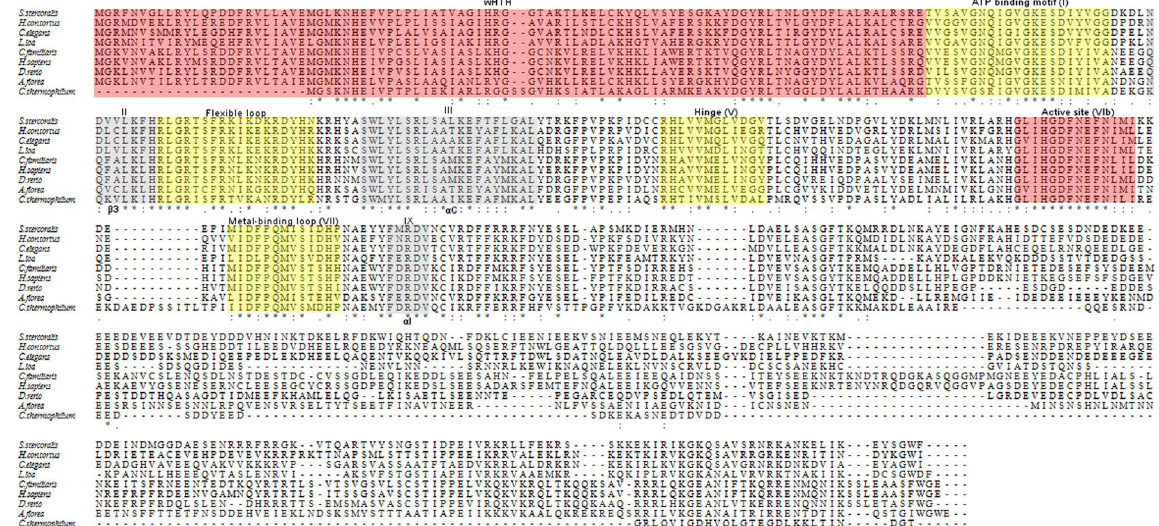
Figure 1. Multiple sequence alignment among predicted RIOK-2 proteins from eight organisms ( Strongyloides stercorali s, Loa loa , Haemonchus contortus , Caenorhabditis elegans , Apis florea , Danio rerio , Canis familiaris , Homo sapiens , Chaetomium thermophilum ). The N-terminal domain contains the conserved wHTH do main (red). The RIO kinase domain contains the ATP-binding motif (yellow), the flexible loop (yellow), the hinge region (yellow), and the catalytic (red) and metal-binding loops (yellow) as determined from the structure of the Archaeoglobus fulgidus RIOK-2 protein. The predicted subdomains I-IX are marked above the alignment. Asterisks indicate identical residues. Dashes indicate gaps in the sequence, included for alignment purposes.